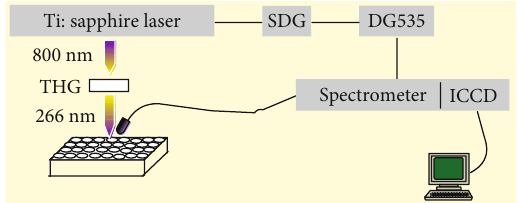
Figure 1: Experiment setup of steady-state PL and nanosecond time- resolved transient photoluminescence (NTRT-PL)